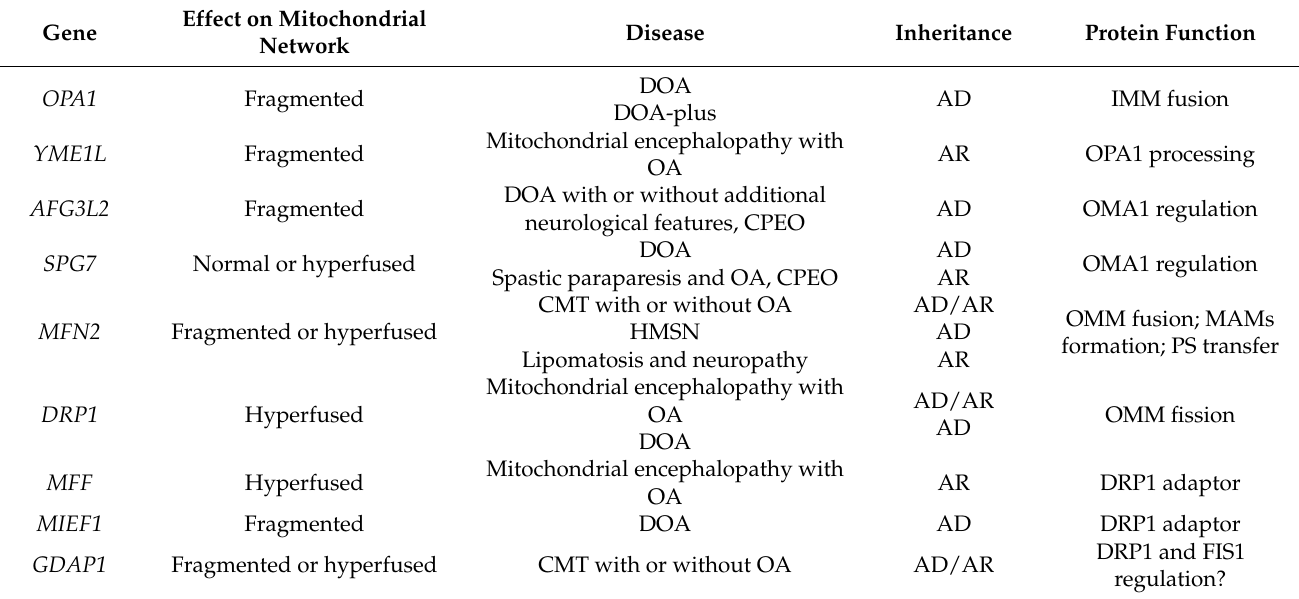
Table 2. Main nuclear genes associated with mitochondrial dynamics dysfunction leading to optic atrophy. Gene